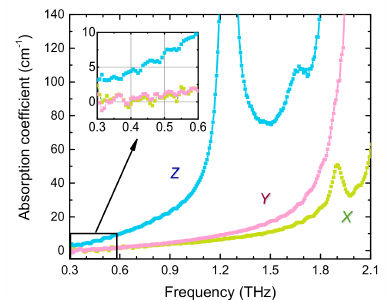
Figure 2. The absorption coe ffi cient of KTA crystal for THz-wave polarized in the direction of di ff erent optical axes (indicated by letters). The inset shows the zoomed long-wavelength range.